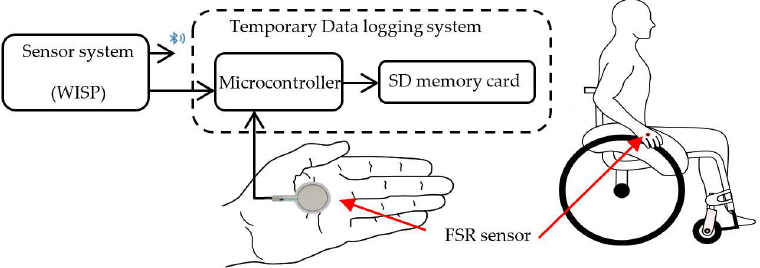
Figure 9. Sensors of WISP are temporary connected to a data logger system. The FSR is added for hand–rim contact detection and only for semi-automatic labeling. FSR serves as reference of PG.